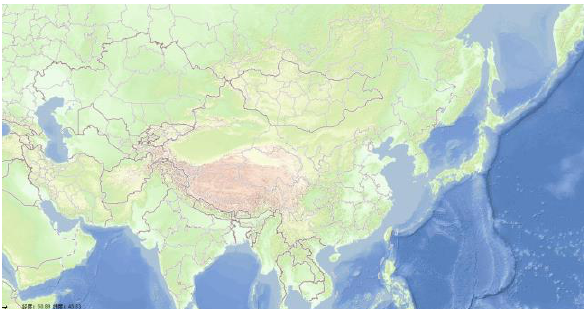
Figure 8. Effect of hypsometric tint for large area